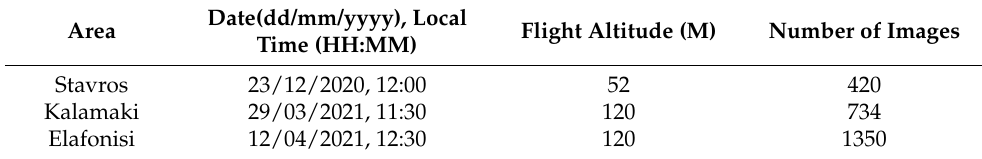
Table 1. Details of drone survey at each study area.